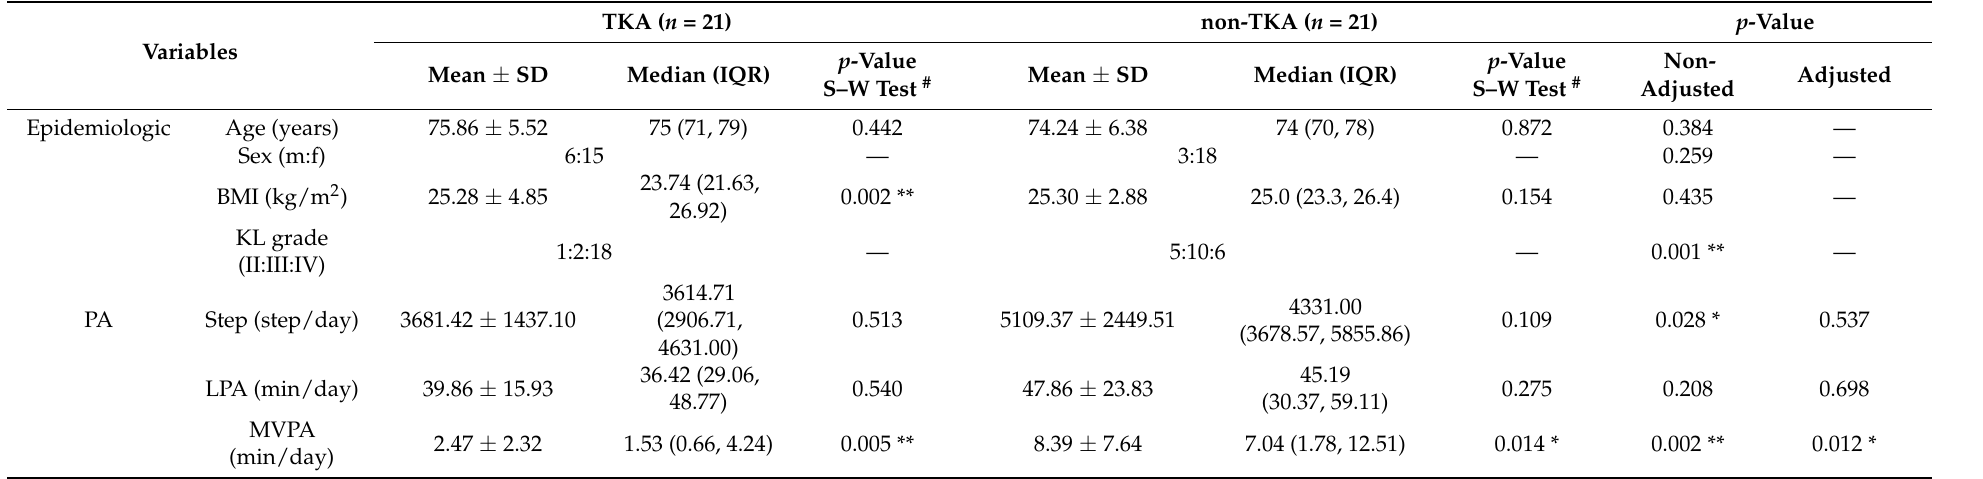
Table 1. Comparison of variable parameters between the TKA and non-TKA